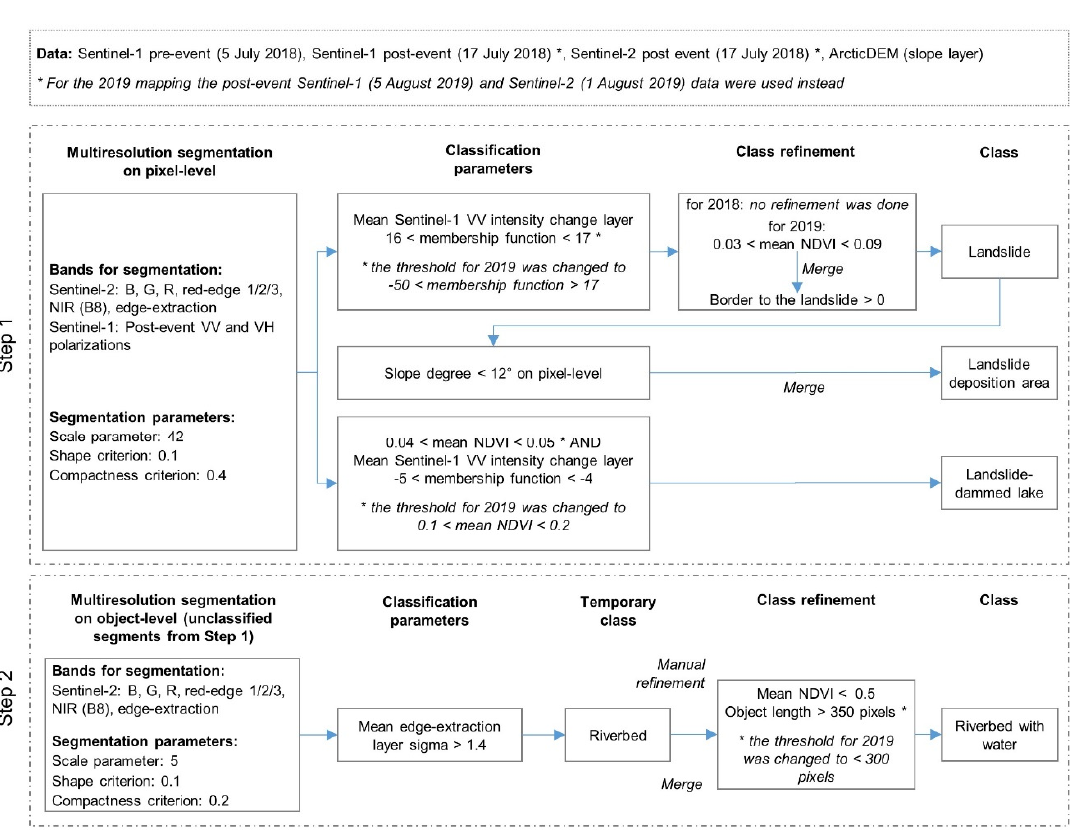
Figure 5. The classification framework used for the post-event geomorphological feature mapping for 2018 and 2019.